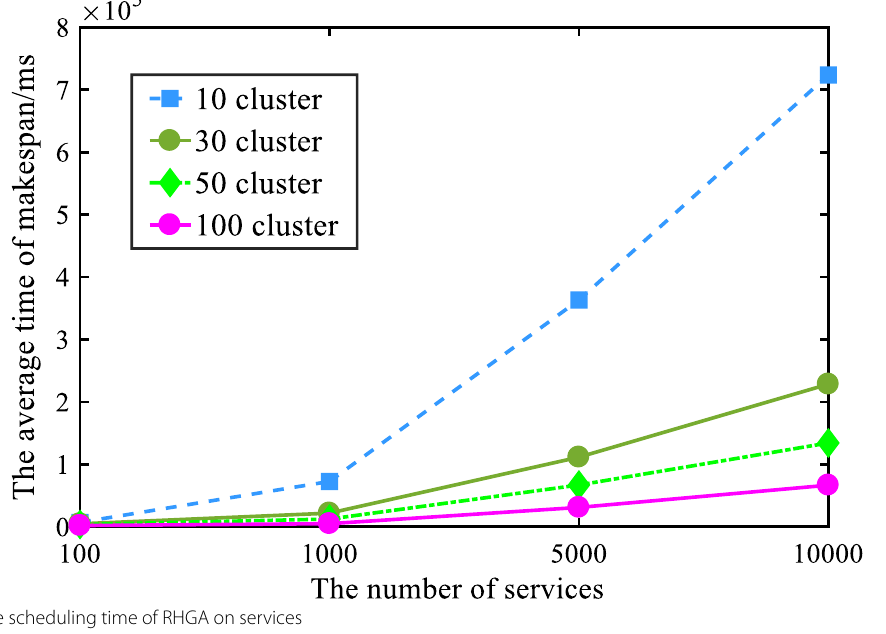
Fig. 7 The average scheduling time of RHGA on services